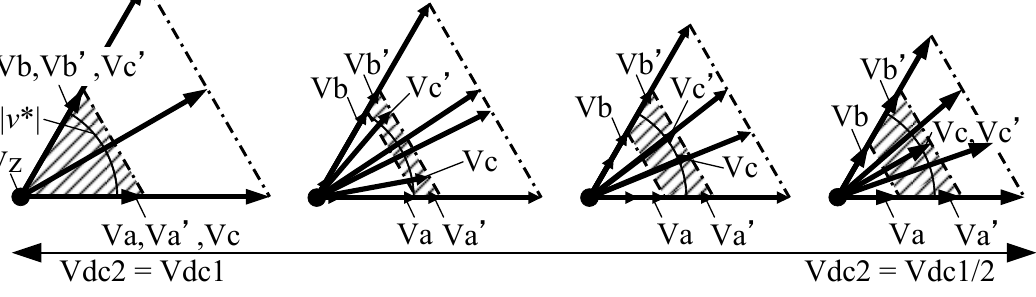
Figure 8. Switching over technique for fault tolerant operation in case of 0.25 < m ≤ 0.5.